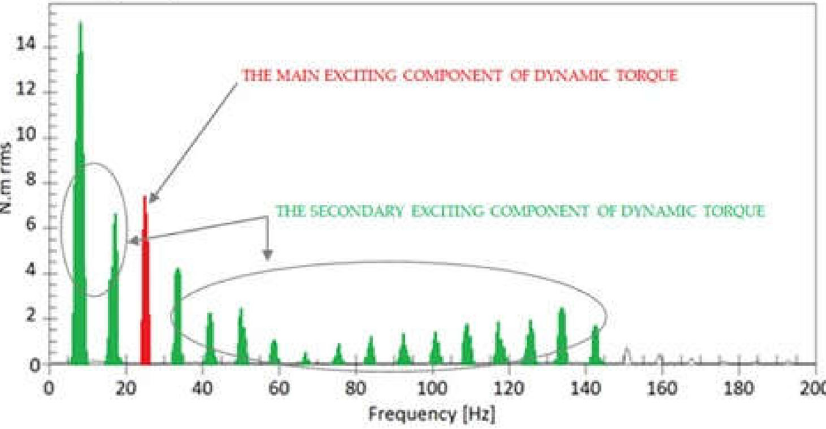
Figure 8. Frequency amplitude spectrum with deactivation of two cylinders in the compressor.